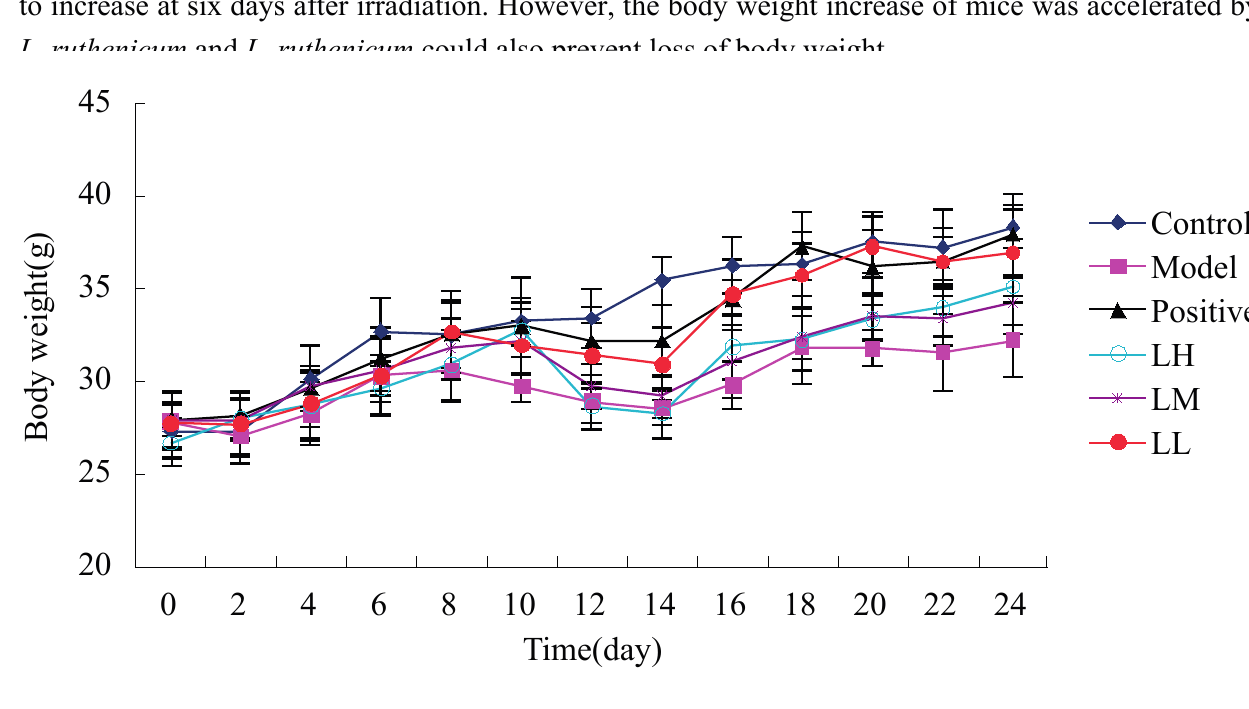
Figure 2. Effect of Lycium ruthenicum Murr. on body weight of irradiated